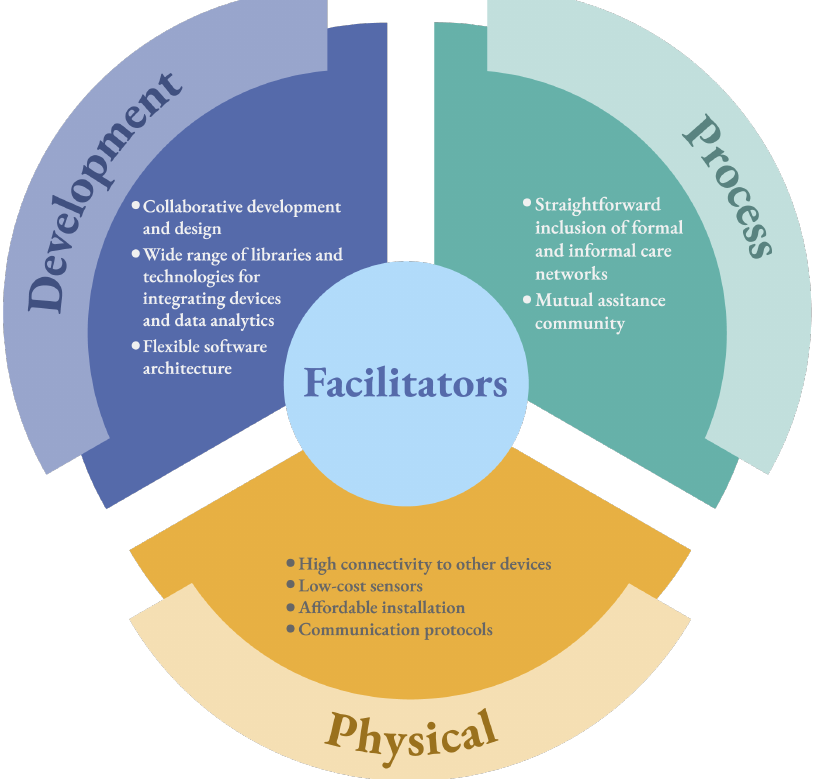
Figure 6. Description of the detected facilitators classified by the system